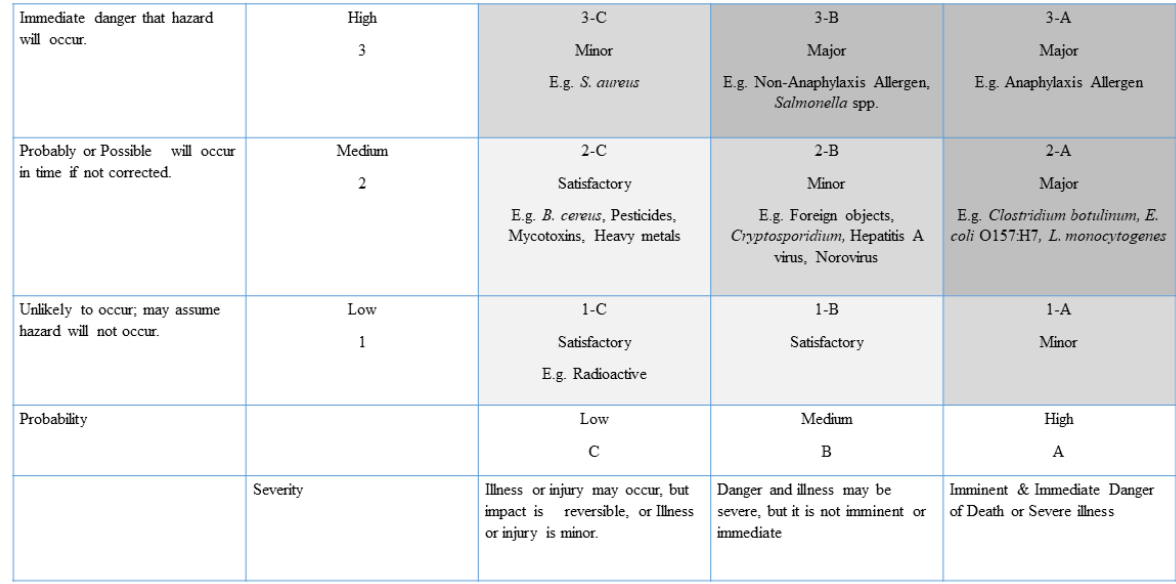
Figure 2. Practical fruit and vegetable 3 × 3 food safety risk matrix model.